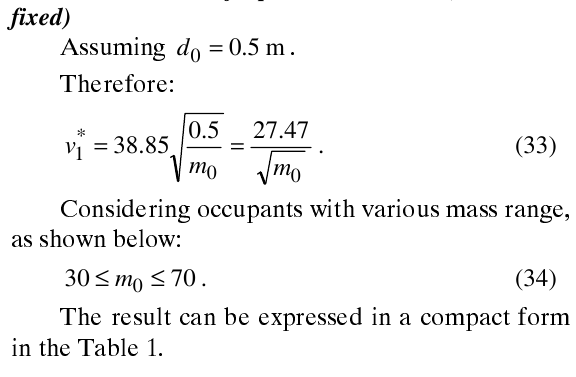
Table 1. Variation of speed with masses (distance is fixed)